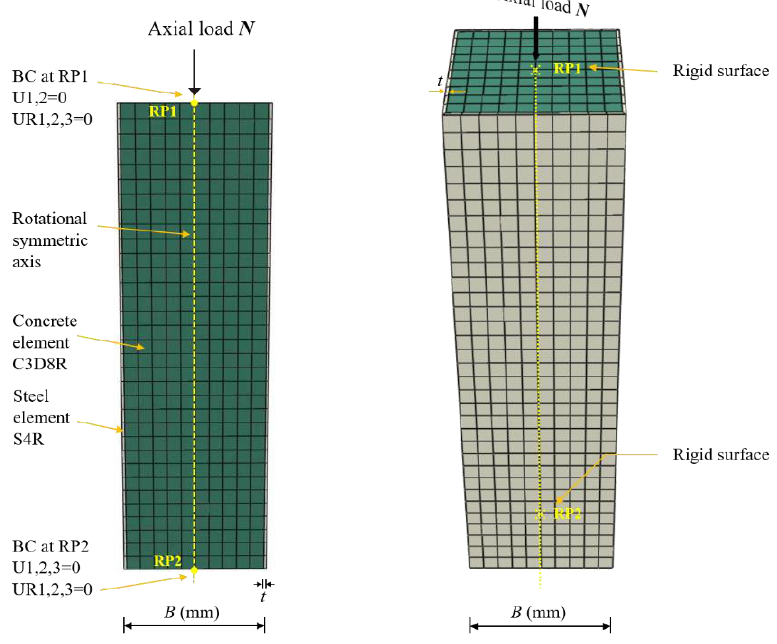
Figure 6. Schematic views of FE meshing and boundary conditions.